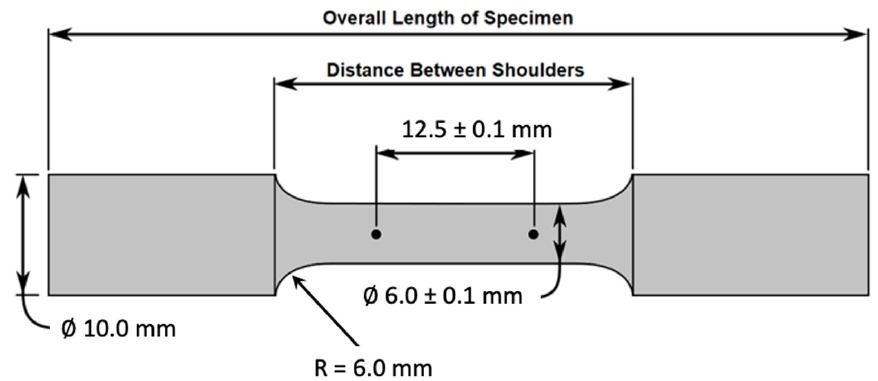
Figure 2. The schematic diagram of tensile specimen.